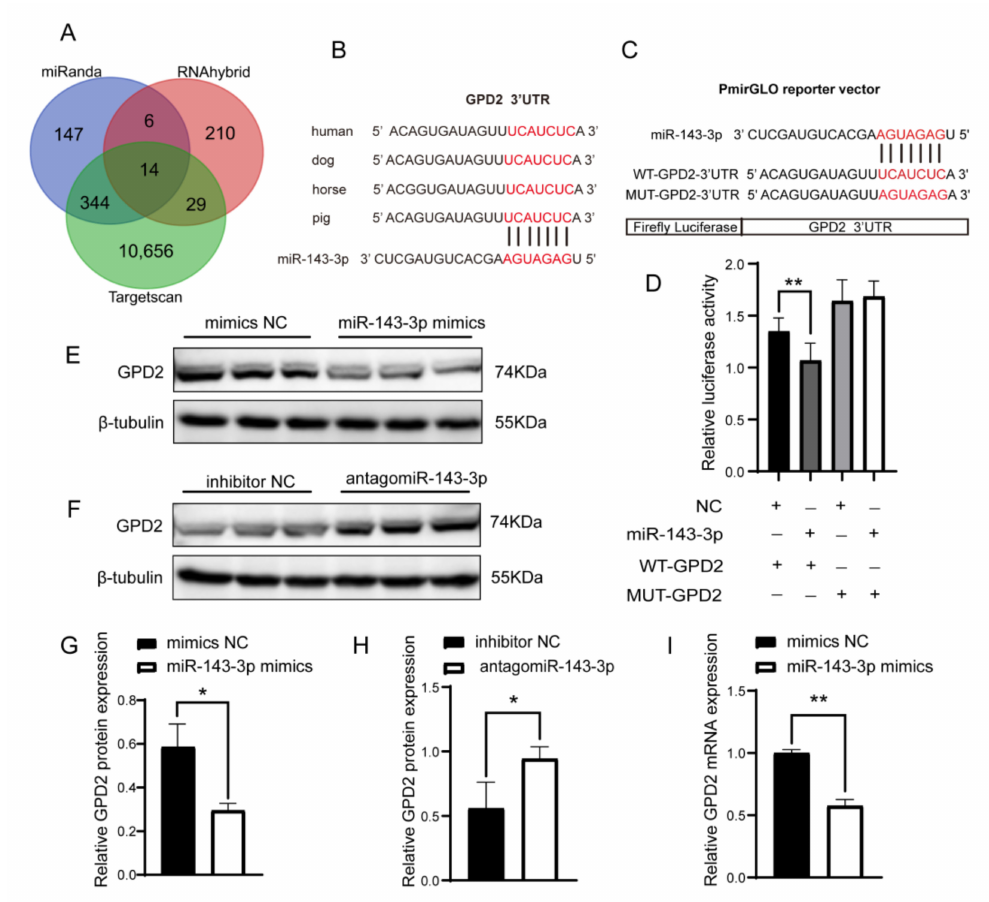
Figure 6. Targeting relationship between glycerol-3-3 phosphate dehydrogenase 2 ( GDP2 ) and miR- 143-3p. ( A ) In total, 14 target genes were predicted by miRanda, RNAhybrid and Targetscan databases. ( B ) The binding fragment of the 3’UTR of GPD2 to the miR-143-3p seed region was highly conserved in different species. ( C ) Dual luciferase vector sequence design. ( D ) Dual fluorescein reporter gene validates direct targeting of miR-143-3p to GPD2 . ( E – H ) Western Blot validates direct targeting of miR-143-3p to GPD2 . ( I ) Validation of miR-143-3p for targeting and regulating GPD2 by RT-qPCR. ** p < 0.01; * p <